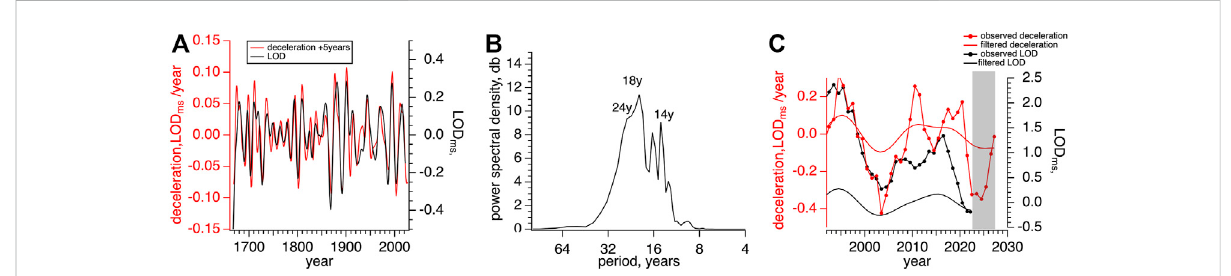
FIGURE 10 Bandpassed (20± 10 years)deceleration (red) and LODdata (black) The deceleration dataare advanced 5 years. (B) The deceleration spectrum of these bandpassed data. Overlapping spectral peaks cause long period interference in the time series (C) shows the most recent 30 years with the lastLODderivedpointinmid-2021atthestartofa5-yearforecastforrelativeseismicquiescence(shadedgrey).Inthe2030decadeEarthrotationis expected to slow (maximum deceleration and maximum LOD), which we show to be associated with increased seismicity and